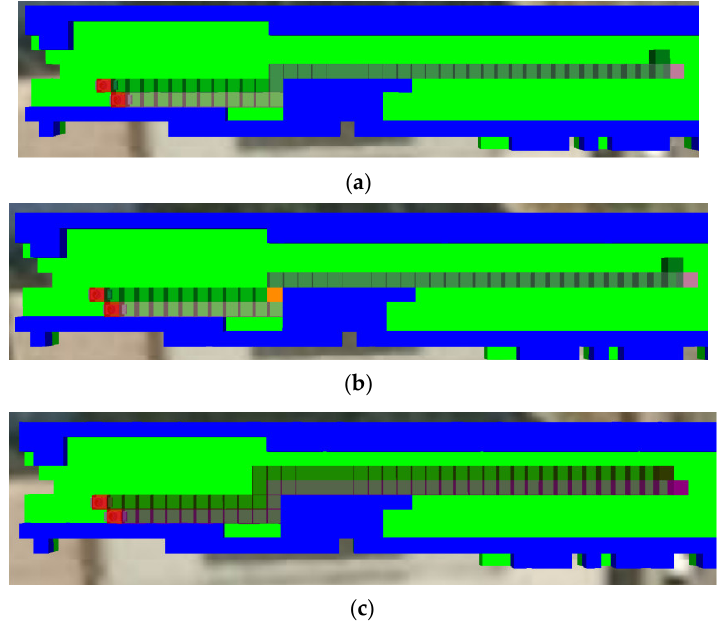
Figure 9. Path Planning Experiment 4. ( a ) Schematic diagram of static A* algorithm path planning; ( b ) collision diagram for static A* algorithm path planning; ( c ) schematic diagram of two-vehicle path planning under the spacetime grid. Blue indicates wall, red indicates starting point, purple indicates the end point, green indicates passable area, grey indicates the path, orange indicates obstacles.